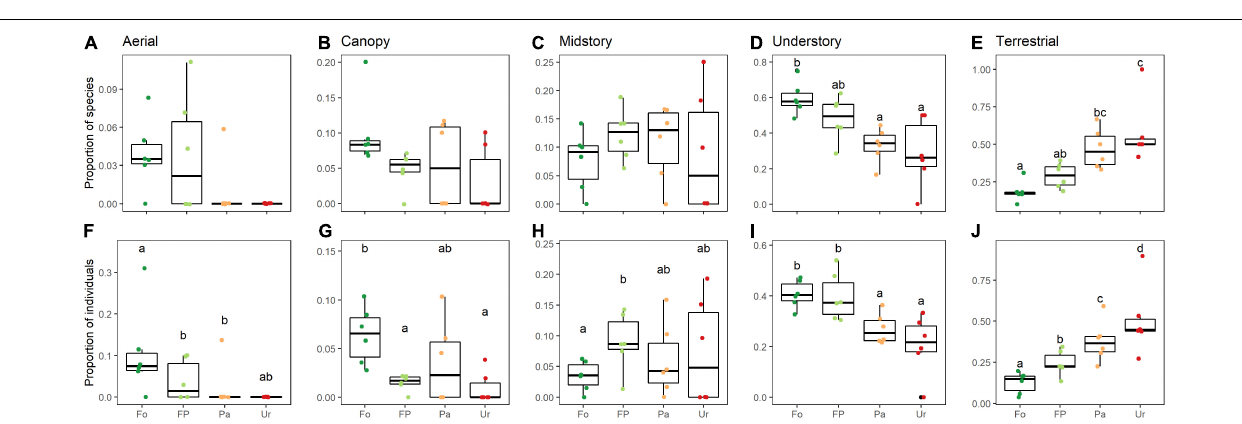
FIGURE 5 | Land-use effects on richness (A–E) and abundance (F–J) of bird foraging strata along an urbanization gradient in the southern Ecuadorian Andes. Aerial (A,F) , canopy (B,G) , midstory (C,H) , understory (D,I) , and terrestrial (E,J) habitats. Panels (A–E) show models from species richness and (F–J) show models from abundance. Data is depicted through quartiles and different lowercase letters above (or below) the whiskers indicate significant differences between land uses (GLM p < 0.05). Fo, forest sites; FP, forest-pasture sites; Pa, pasture sites; Ur, urban